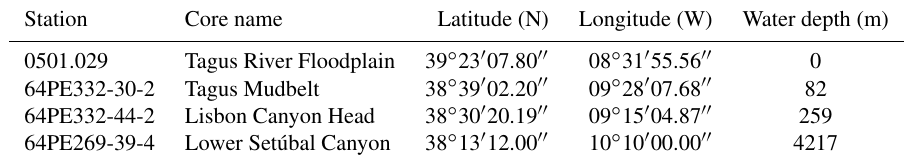
Table 1. Stations, sediment core names, locations of sampling, and water depth for each sediment core used in this study. Station